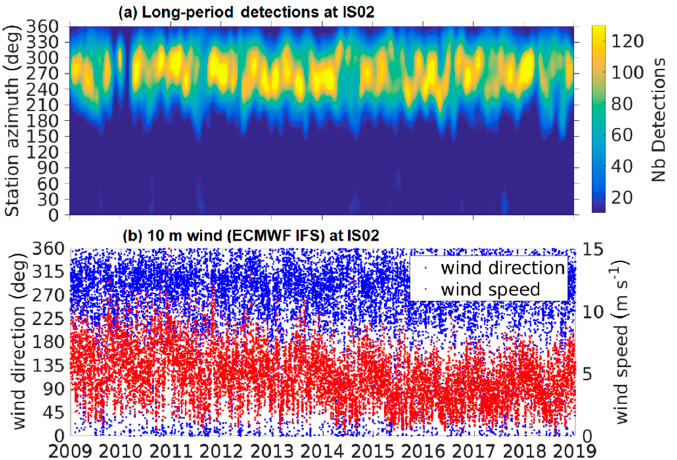
Figure 8. Similar to Figure 5, but for IS02 at the southern tip of South America. ( a ) shows detections resulting from the short-period PMCC configuration; whereas the long-period configuration is represented in ( b ).